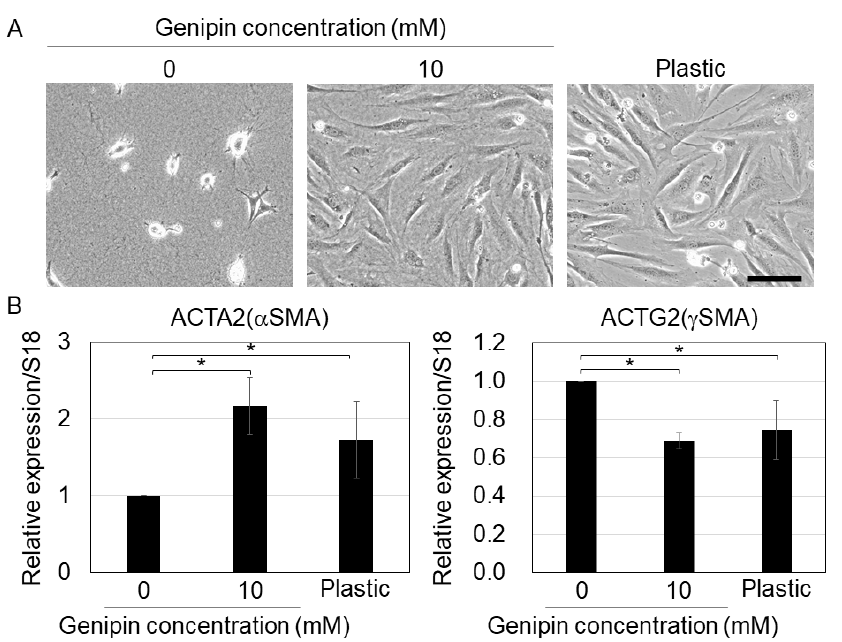
Figure 4. ( A ) Cell morphology of mouse mesenchymal stromal cells on the 0 or 10 mM genipin-mixed collagen gels or collagen-coated plastic substrates with smooth muscle-differentiation condition. Scale bar = 100 μ m. ( B ) qPCR of ACTA2 and ACTG2 in ( A ). S18 was used as an internal control. Mean ± S.D. N = 3 independent experiments. * Statistical significance determined with 95% confi- dence interval with Bonferroni correction.